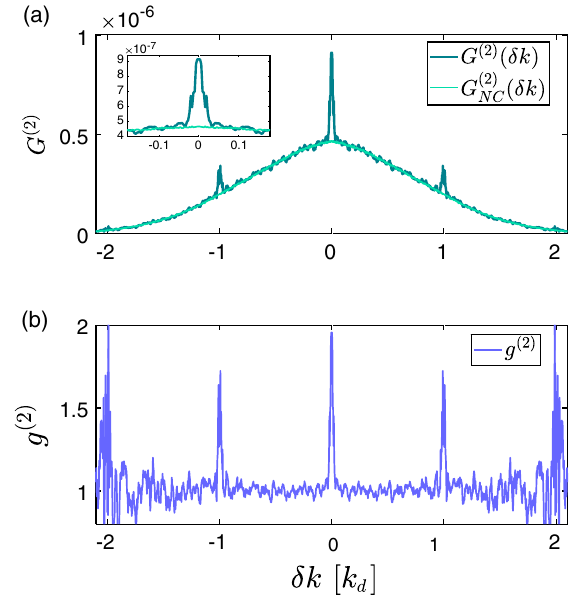
FIG. 7. Correlation functions. Value of the different correlation functions along the x axis for the data displayed in Fig. 2.